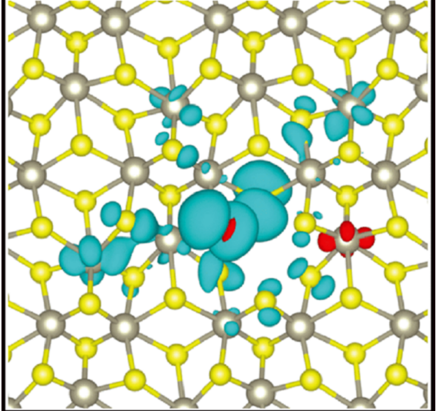
Figure 5. The spin resolved charge density for Re vacancy. Bule (red) colors represent spin up (down) electrons. (Reprinted figure with permission from [57]. Copyright (2014) by the American Physical Society.)